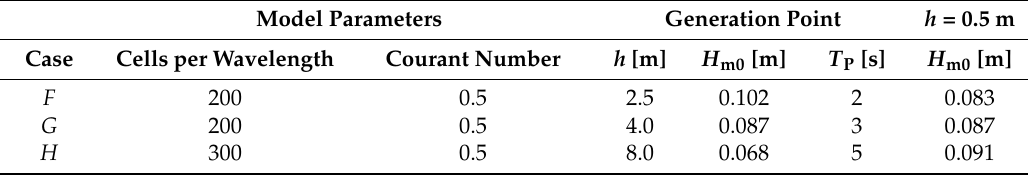
Table 1. Wave conditions of the irregular waves at the generation point in COULWAVE.